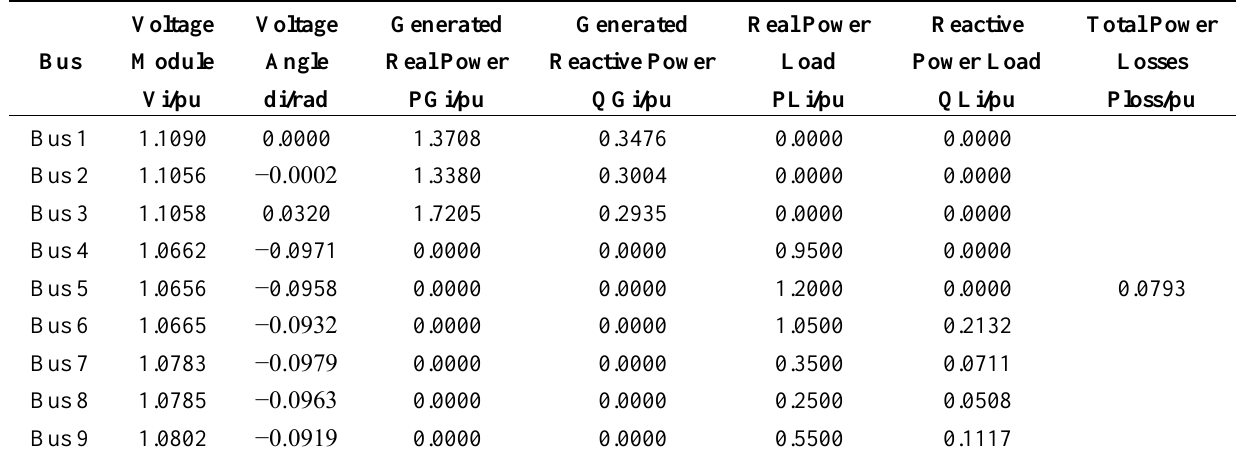
Table 8. The behavior of the test system with OOP.